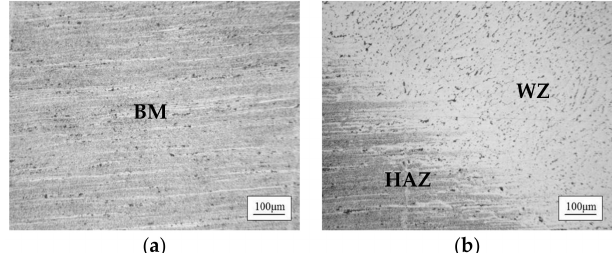
Figure 8. Optical microstructures of different zones of welded joints at low magnification that were welded using 1.2 mm Al-5Mg-0.12Zr wire electrodes: ( a ) BM (base metal); ( b ) HAZ (heat-affected zone) and WZ (weld